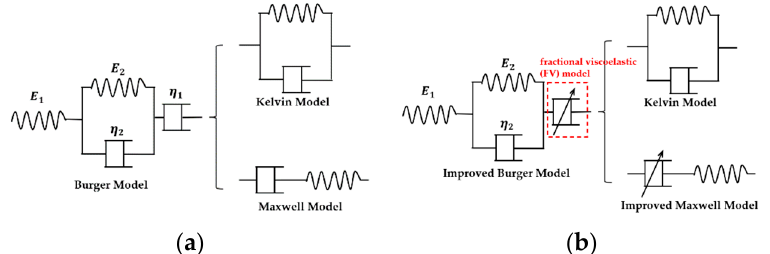
Figure 5. The expression model for creep. ( a ) The traditional Burger model; ( b ) the improved Burger model that integrates the FV model.